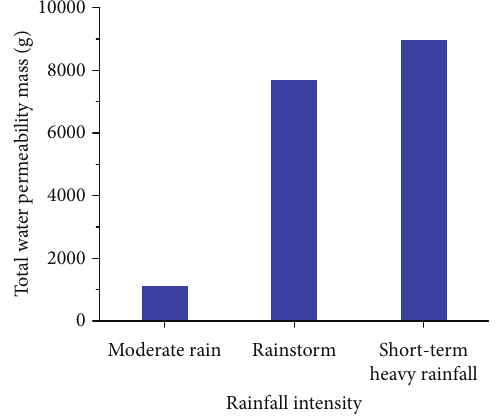
Figure 5: Total water permeability mass under di ff erent